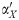
Association was detected in 25 out of 25 datasets with underlying association in the moderate Pearson correlation coefficient (0.35–0.63) group: The figure is arranged in exactly the same way as Figs 5 and 9 datasets have been shown.BPA for combinations of various αX′ and αY′ are shown as a heatmap for 9 datasets. Below every heatmap, a scatterplot of the actual data is shown. Also, a black line shows the relationship function that was calculated by curve fitting approaches. On the top left of the heatmap, the unique index of every dataset is presented. On the top of the heatmap Pearson correlation coefficient (PC) along with the p-value in brackets and the normalized mutual information content (MI) for the dataset is given. On the top of the scatterplot, the Spearman rank correlation coefficient (SR) and the Kendall tau rank correlation coefficient (KT) are given.